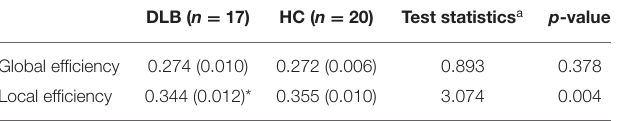
TABLE 3 | Static brain network properties of each